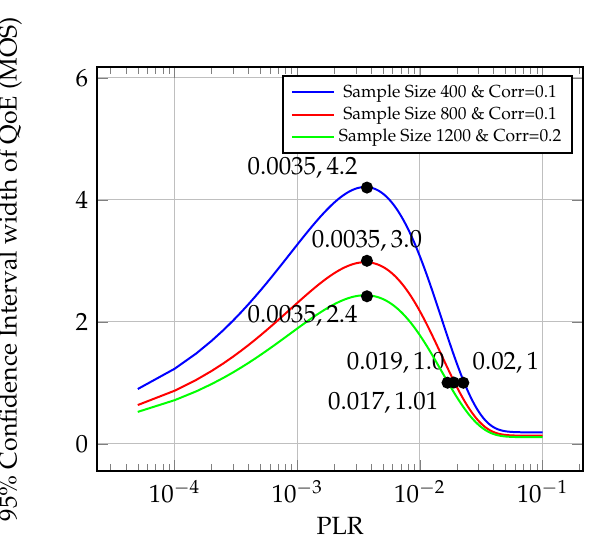
Figure 2. Propagated uncertainty in QoE vs. PLR at jitter = 10 ms with correlation.